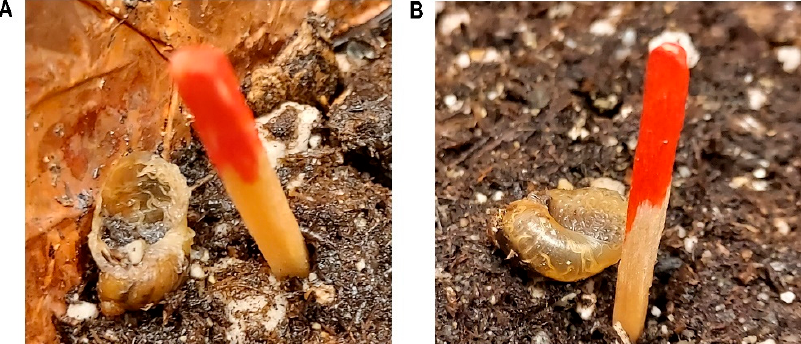
Figure 1. Dead Succinea snails with mixed stages of Phasmarhabditis nematodes present four days after being exposed to the recommended dose of Phasmarhabditis (30 IJs/cm 2 ) ( A , B ).